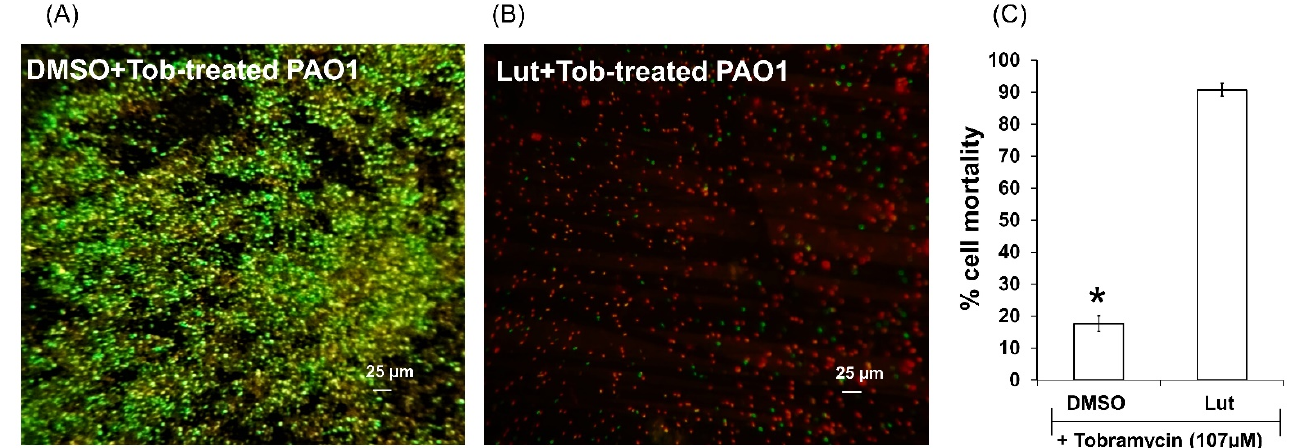
Figure 5. Synergistic activity of Lut and tobramycin against biofilm-encapsulated PAO1. PAO1 cells were incubated statically for 24 h and then treated for 24 h with tobramycin (107 µM final concentration) and DMSO 1% or Lut (22 µM final concentration). ( A ) DMSO + tobramycin, ( B ) Lut + tobramycin. ( C ) Quantification of bacterial viability. Assessment of bacterial viability and microscopy were performed as in Figure 4. Red color indicates dead cells and green/yellow colors indicate alive cells. Error bars represent the standard errors of the means; all experiments were performed in quintuplicate with three independent assays, and asterisk indicates significant difference from the DMSO ( p < 0.01).